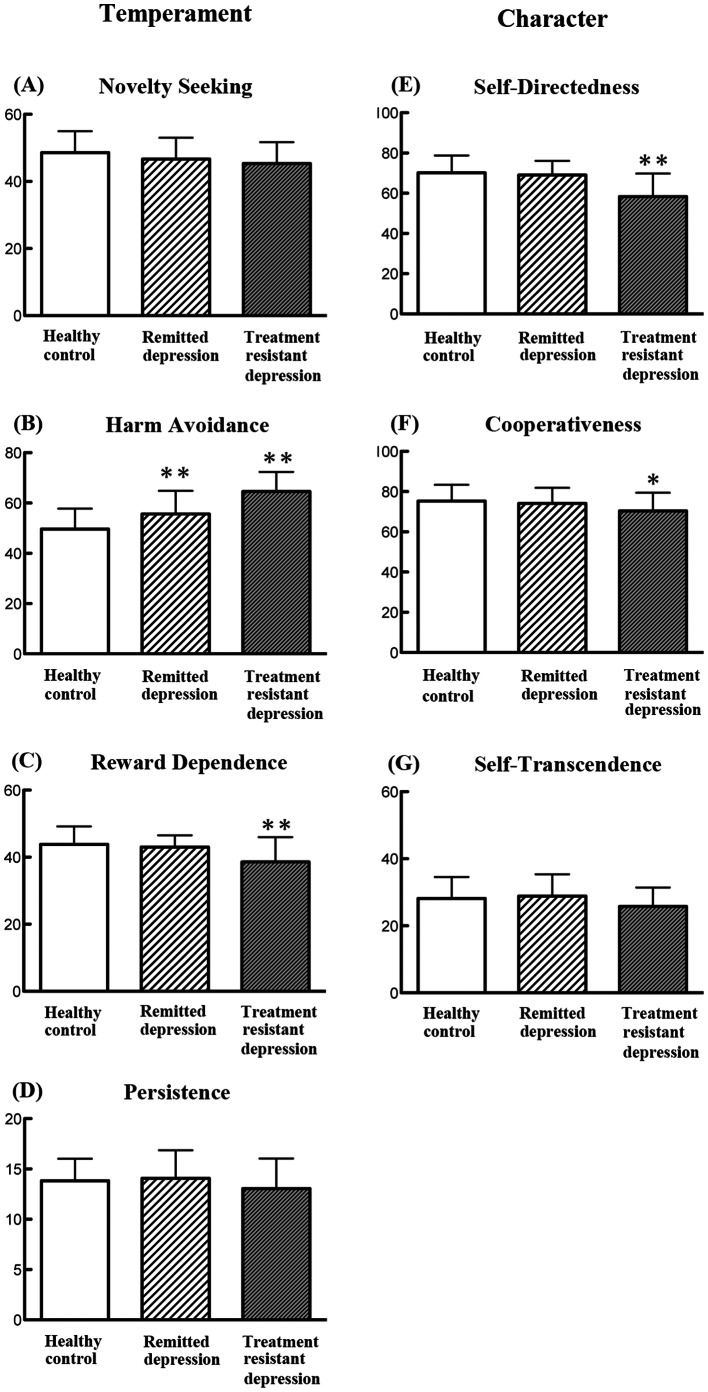
The data of TCI.Analysis of variance (ANOVA) shows a significant difference between three groups for (B) Harm Avoidance (F (2,237) = 50.58; P<0.001), (C) Reword Dependence (F (2,237) = 13.19; P<0.001), (E) Self-Directedness (F (2,237) = 25.98; P<0.001), and (F) Cooperativeness (F 2,237) = 5.42; P = 0.005). There are not significant differences between three groups in (A) Novelty seeking, F (2,237) = 4.44, p = 0.013, (D) Persistence, (F (2,237) = 1.81, P = 0.167, and (G) Self-transcendence, F (2,237) = 2.51, P = 0.084. *P<0.01, **P<0.001 compared to control (ANOVA followed by Scheffe’s test).